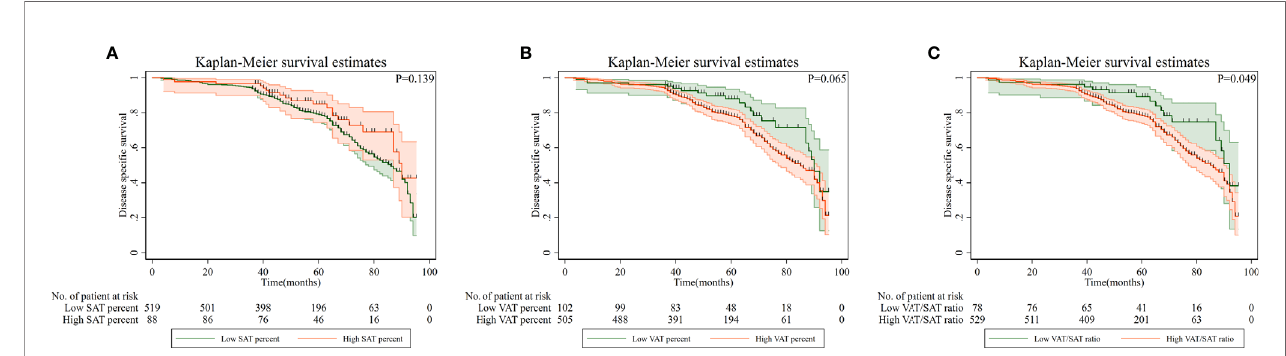
FIGURE 3 | Disease-speci fi c survival of patients with gastric cancer according to adipose tissue distribution parameters. (A) High SAT percentage; (B) High VAT percentage; (C) High SAT/VAT ratio. VAT, visceral adipose tissue; SAT, subcutaneous adipose tissue.